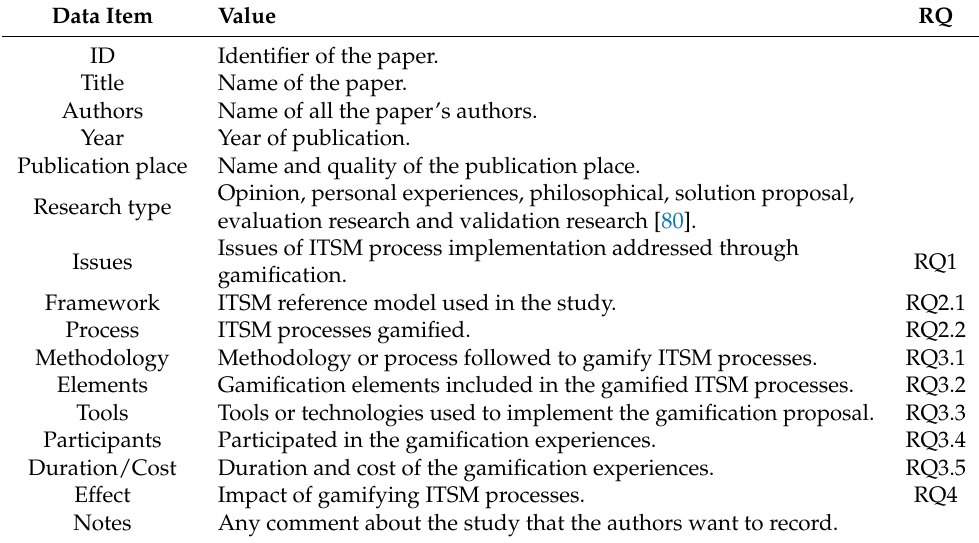
Table 8. Data extraction form.